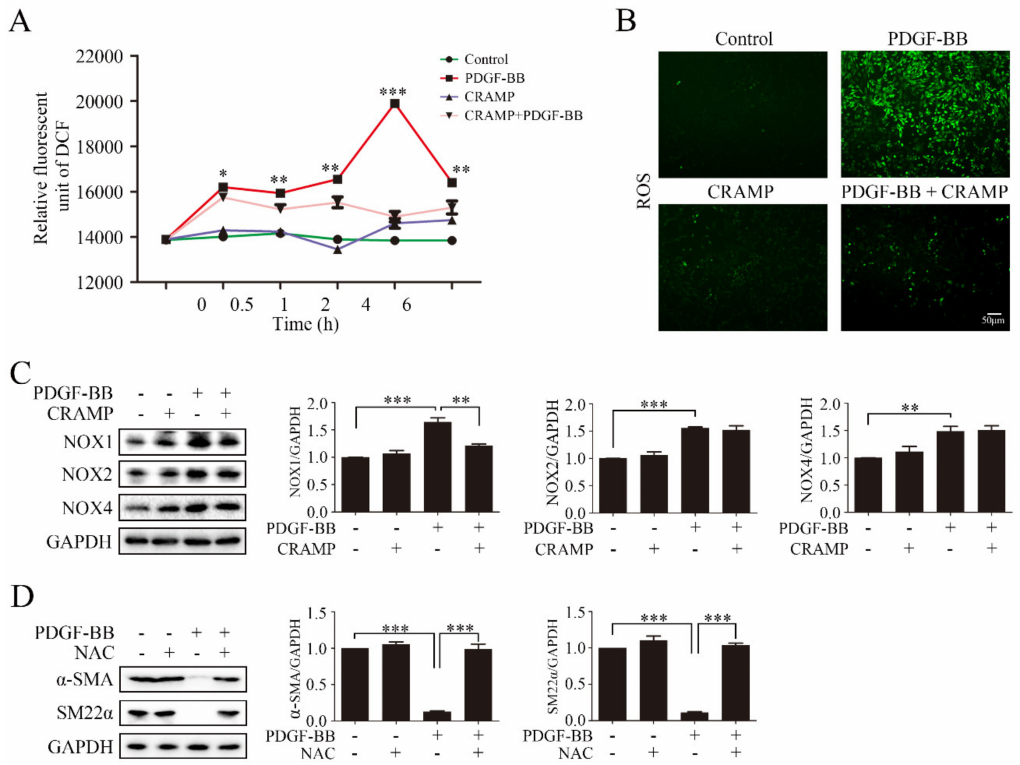
Figure 6. CRAMP prevented PDGF-BB-enhanced ROS by targeting NOX1. ( A ) VSMC were pretreated with CRAMP (100 ng / mL) for 2 h and then stimulated with PDGF-BB (20 ng / mL) at di ff erent times (0.5, 1, 2, 4, 6 h). The level of ROS was detected using fluorescence microplate reader. Data of 3 independent experiments is presented as mean ± SEM. * p < 0.05, ** p < 0.01, *** p < 0.001 compared with control, n = 5. ( B ) VSMC were pretreated with CRAMP (100 ng / mL) for 2 h and then stimulated with PDGF-BB (20 ng / mL) for 4 h. The level of ROS was detected by immunofluorescence detection. ( C ) VSMC were pretreated with CRAMP (100 ng / mL) for 2 h and then stimulated with PDGF-BB (20 ng / mL) for 24 h following by immunoblotting with anti-NOX1, anti-NOX2 and anti-NOX4 antibodies. ( D ) VSMC were pretreated with CRAMP (100 ng / mL) for 2 h and then stimulated with PDGF-BB (20 ng / mL) for 24 h followed by immunoblotting with anti- α -SMA and anti-SM22 α antibody. Data of 3 independent experiments is presented as mean ± SEM. * p < 0.05, ** p < 0.01, *** p < 0.001 compared with control, n =